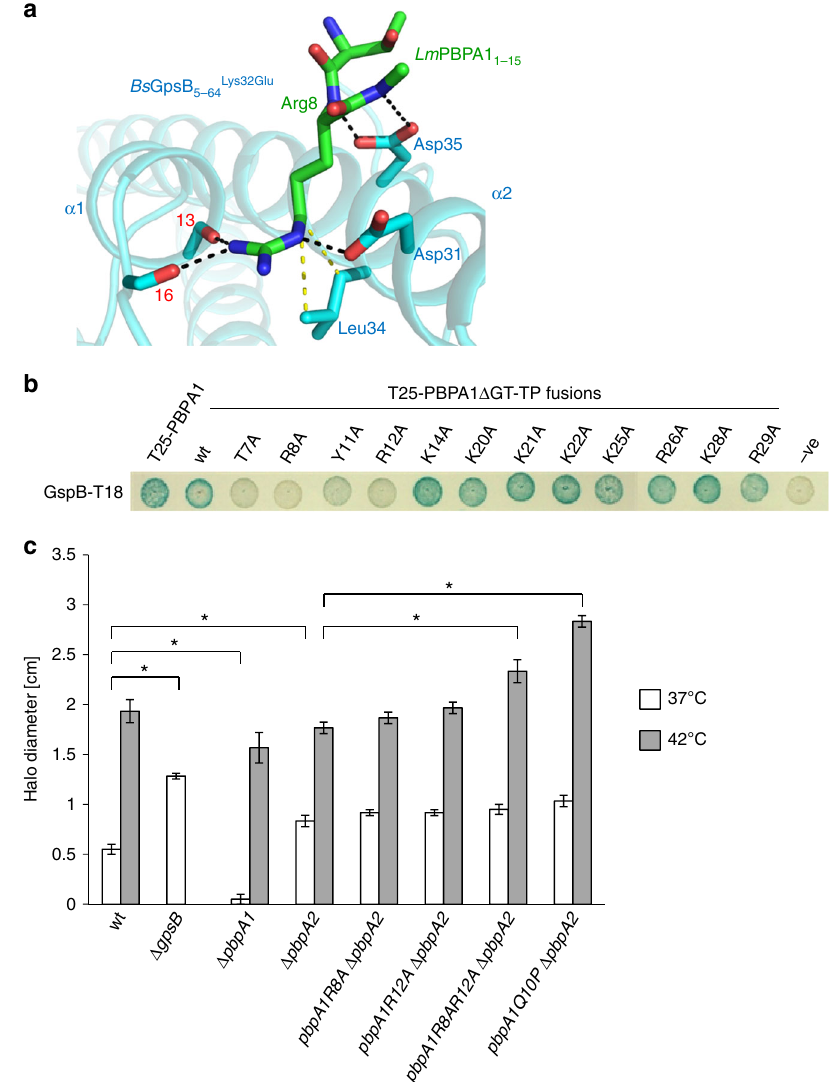
Fig. 2 The Lm GpsB: Lm PBPA1 interactions are also governed by a conserved arginine. a The structure of the Bs GpsB 5-64 Lys32Glu : Lm PBPA1 1-15 complex reveals that only Arg8 and adjacent backbone atoms of the Lm PBPA1 1-15 peptide are ordered. In this cartoon, Bs GpsB 5-64 Lys32Glu is coloured cyan and selected sidechains are drawn as stick with cyan carbons, whereas the Lm PBPA1 1-15 peptide is represented in stick form, with green carbons. The carbonyl oxygens of Bs GpsB Ile13 and Bs GpsB Lys16 are denoted by respective red numerals. Hydrogen bonds are shown as black dashed lines and the van der Waals ’ interactions between Bs GpsB Leu34 and Lm PBPA1 Arg8 are in yellow. Only one PBP-binding site is occupied by peptide in these crystals because the second site is blocked by crystal contacts. b Mutation of conserved Lm PBPA1 residues results in a loss of interaction by BACTH. The removal of residues 92 – 827, correlating to the glycosyltransferase and transpeptidase domains of Lm PBPA1, results in the PBPA1 Δ GT-TP peptide. Empty pKT25 ( − ) was used as a negative control. Agar plates were photographed after 24 h at 30 °C. c Effect of N-terminal pbpA1 mutations on fosfomycin sensitivity of a Δ pbpA2 mutant. Wild-type and mutant L. monocytogenes EGD-e strains were grown as con fl uent layers on BHI agar plates at 37 °C and 42 °C and halo diameters around fosfomycin-containing fi lter discs were measured and corrected for the disc diameter. The experiment was performed in triplicate, and average values and standard deviations are shown. Asterisks indicate statistically signi fi cant differences ( P < 0.01, t